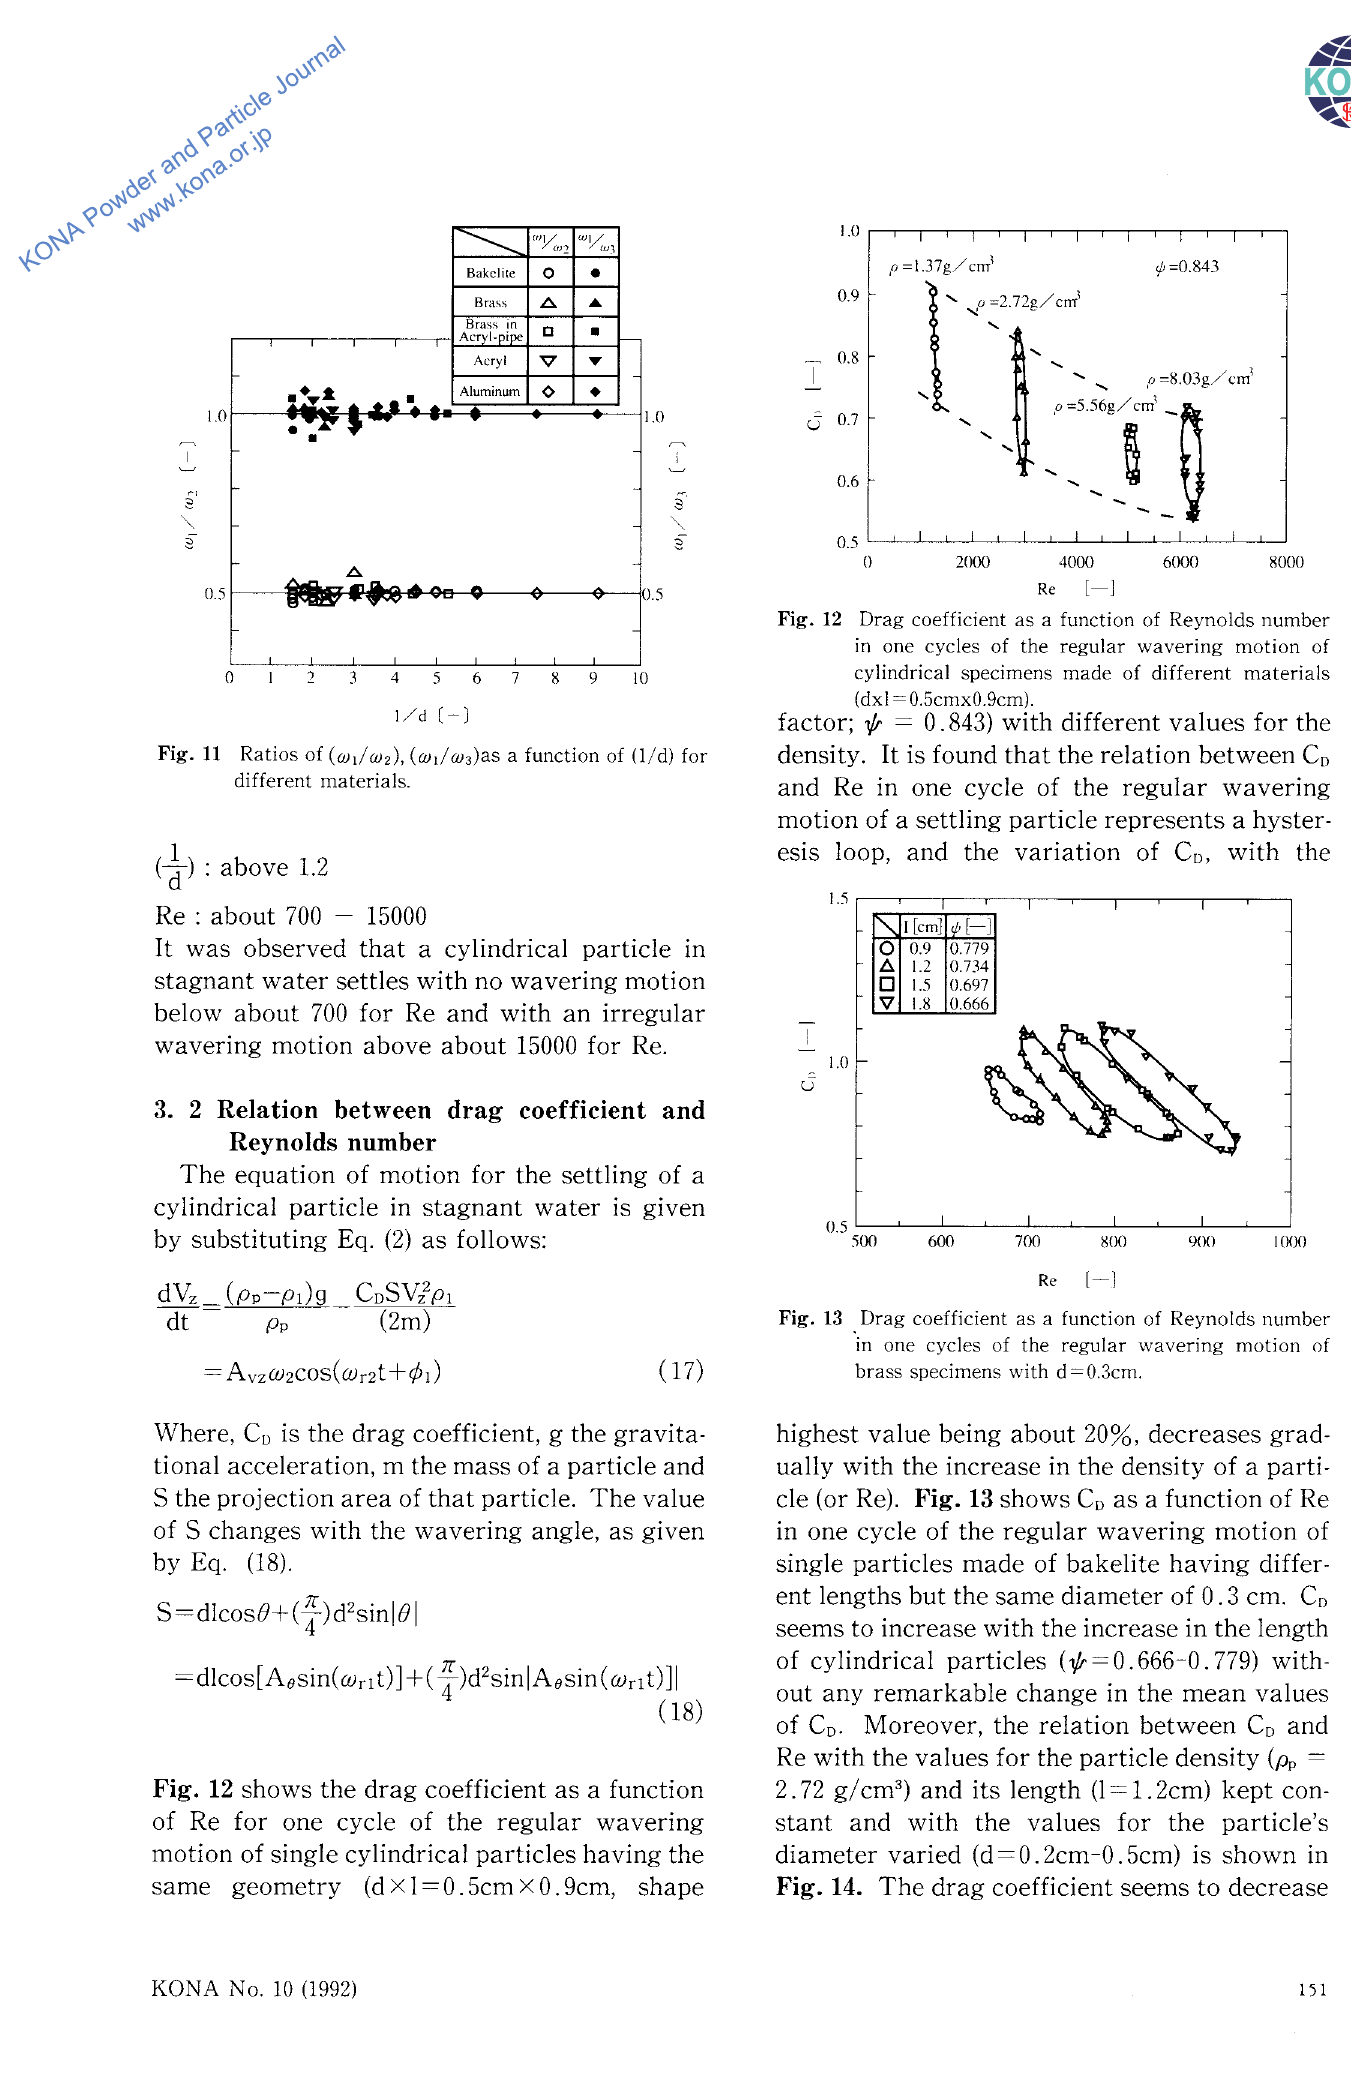
Fig. 12 Drag coefficient as a function of Reynolds number in one cycles of the regular wavering motion of cylindrical specimens made of different materials (dxl = 0.5cmx0.9cm). factor; f = 0. 843) with different values for the Fig. 11 Ratios of (w )as a function of (1/d) for 1 /w 2), (w 1 /w 3 different materials.